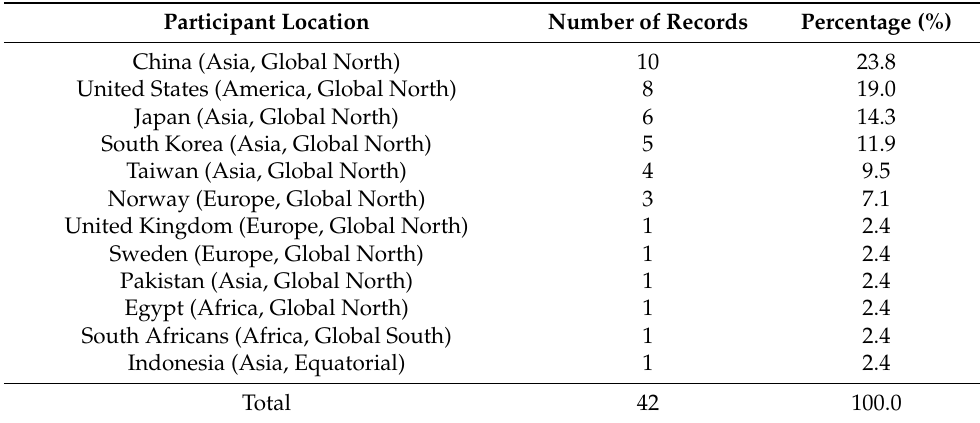
Table 2. Statistics of geographical distribution of the included